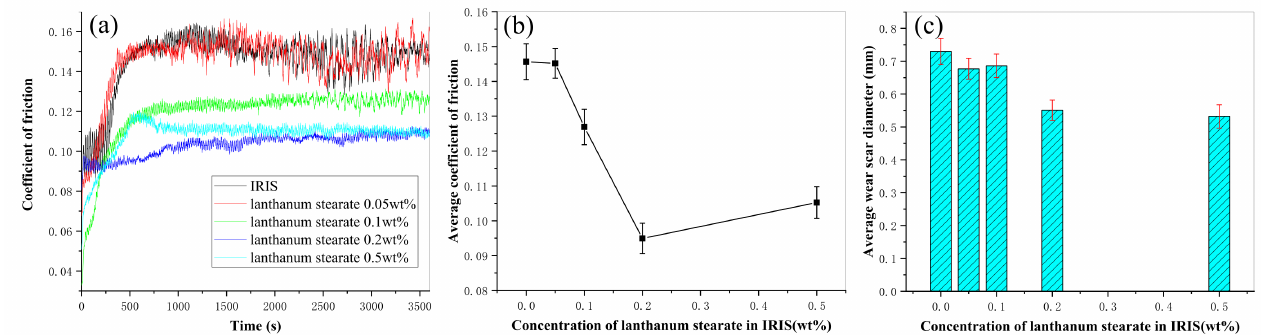
Figure 12. Variations of CoF and wear mark size of LSMLO with different addition amounts. ( a ) CoF; ( b ) average CoF; ( c ) average wear scar